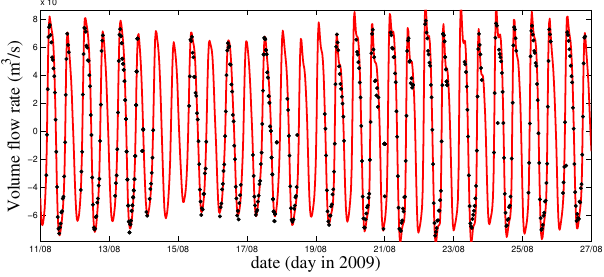
Figure 9. Time series of volume flow rate across the Texel Inlet as obtained from the TESO ferry measurements (black dots) and from the numerical simulations (red line) for 16 days in August 2009.